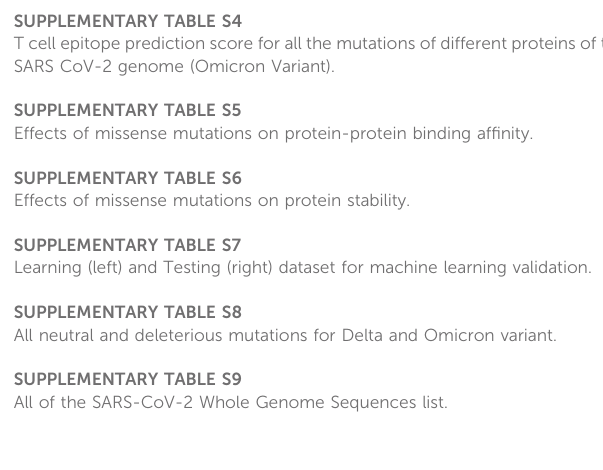
SUPPLEMENTARY TABLE S4 T cell epitope prediction score for all the mutations of different proteins of the SARS CoV-2 genome (Omicron Variant).